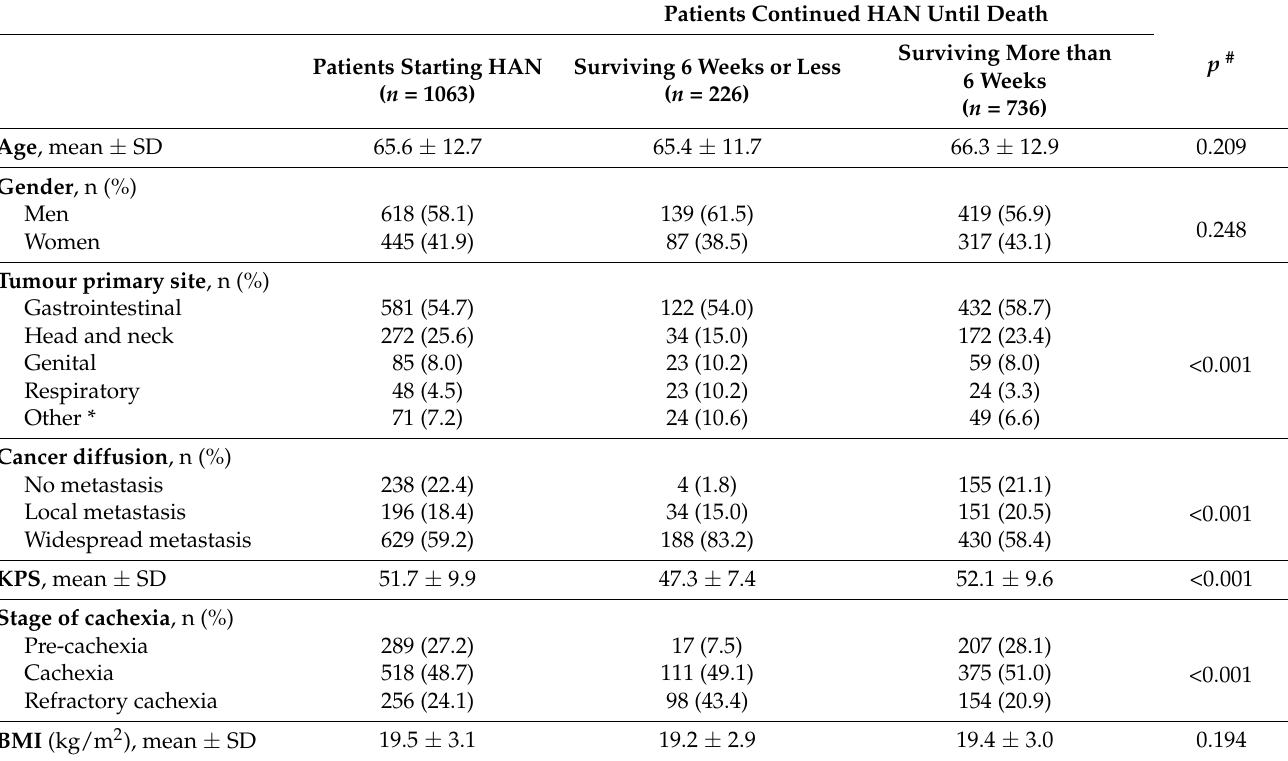
Table 2. Baseline characteristics of the patients starting